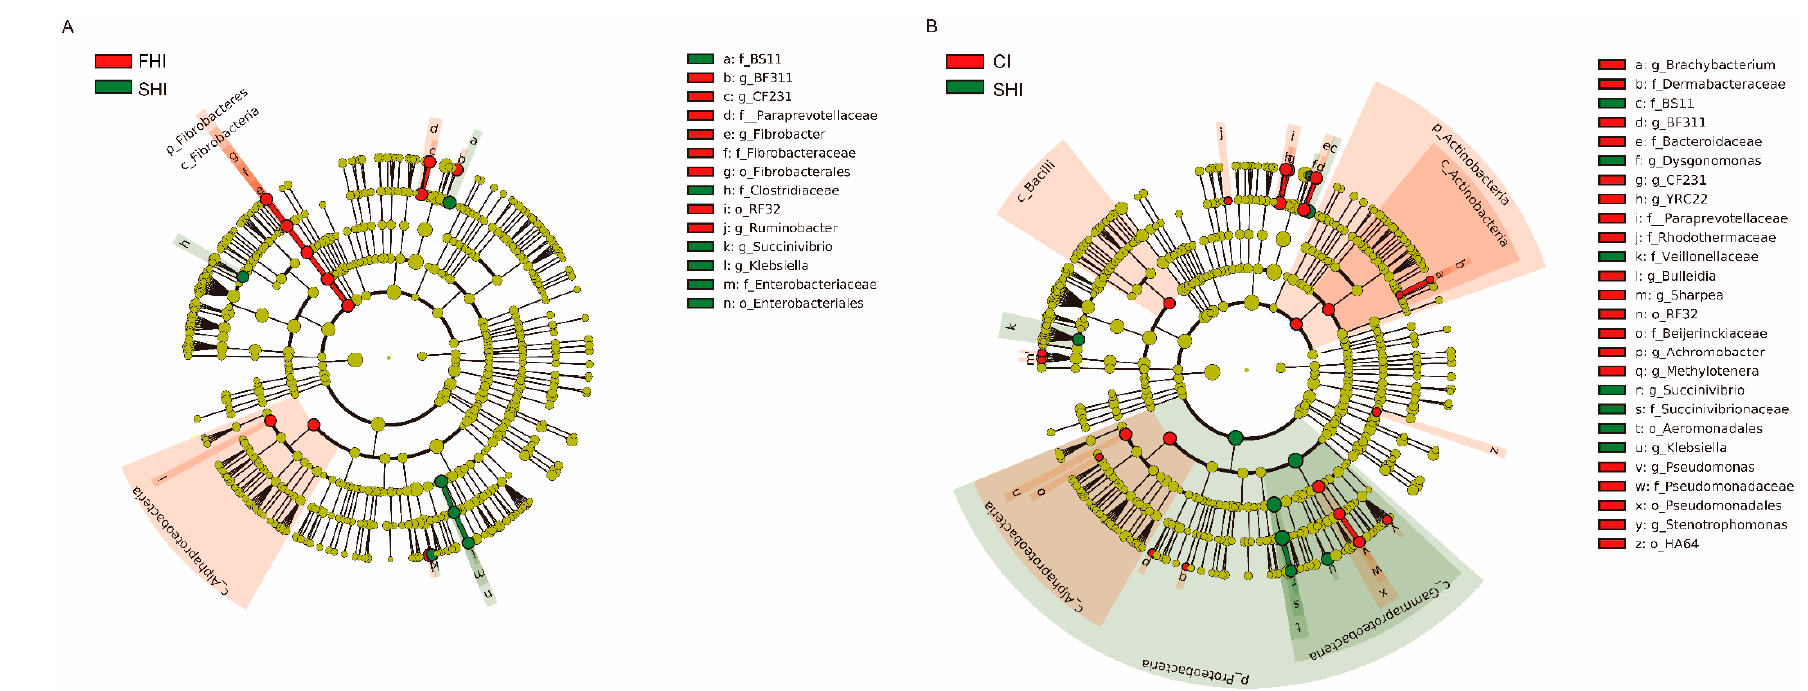
Figure 5. The differential phylogenetic distribution of bacterial communities between FHI and SHI ( A ) and between CI and SHI ( B ). LEfSe was used to determine the differentially relative abundance of bacterial taxa. Only LDA scores above 3 and P-value smaller than 0.05 were shown. LEfSe, linear discriminant analysis (LDA) effect size; FHI, first half infusion of maltodextrin; SHI, second half infusion of maltodextrin; CI, continuous infusion of maltodextrin.